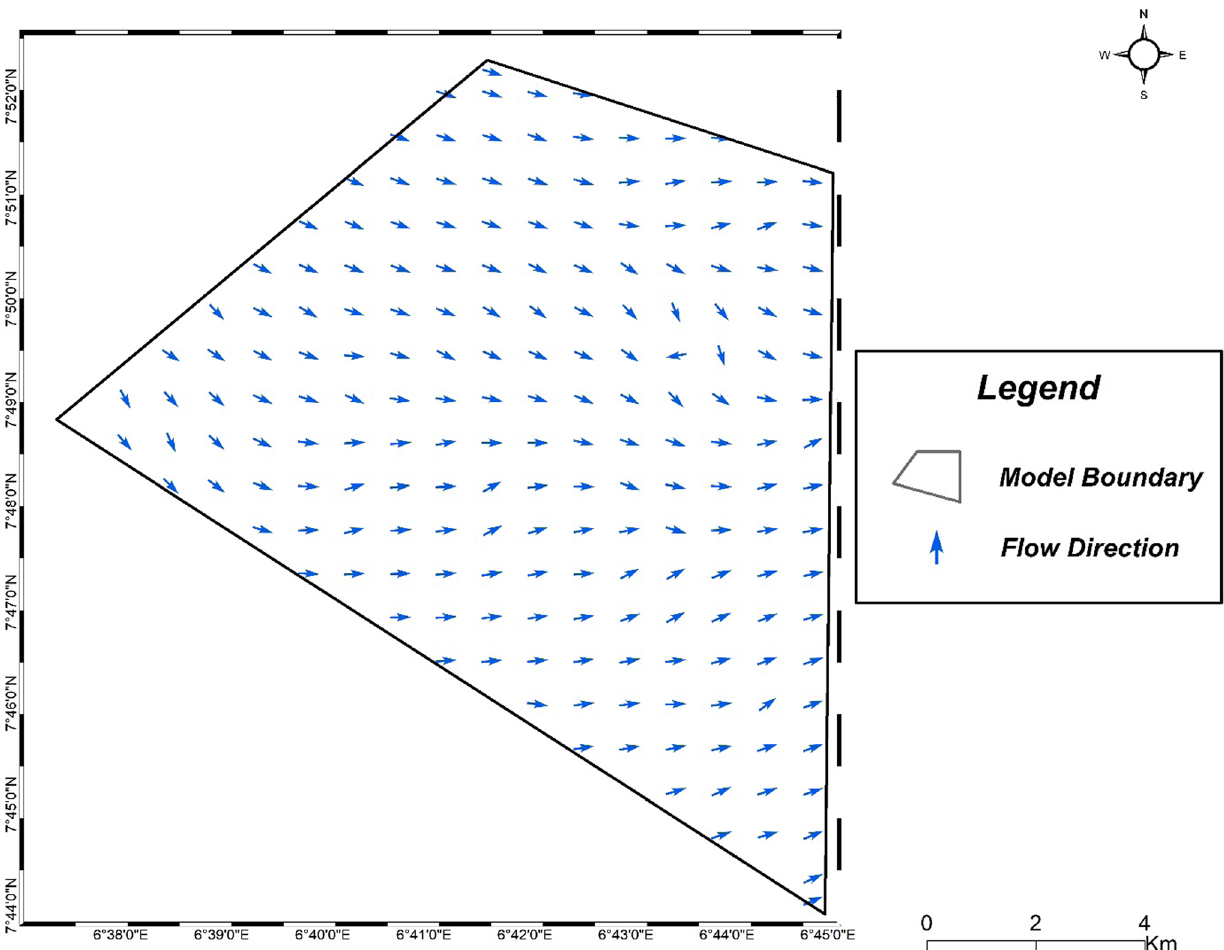
Fig. 9 Map showing the groundwater flow direction across the study area